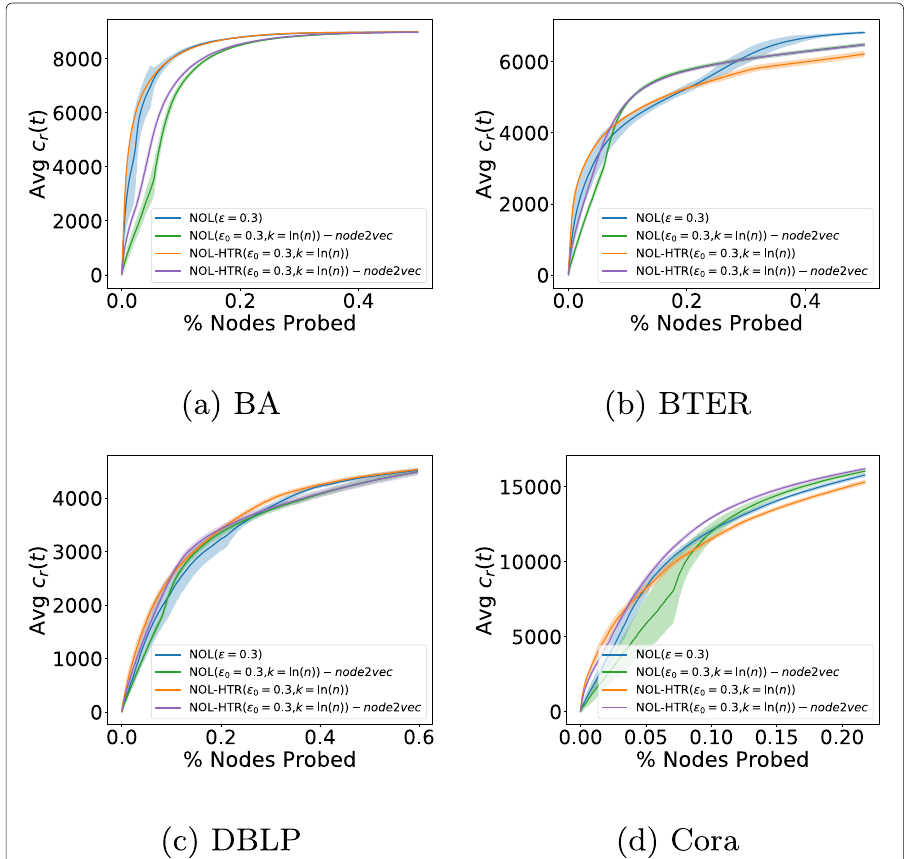
Fig. 10 Cumulative reward results using node2vec features. Improvement using the embedding as features is not straightforward. In the BA and DBLP cases, performance is the same or worse. In the BTER case, performance improves towards the beginning, but does not decisively outperform the default features in the end. Only in Cora does it appear that NOL-HTR with node2vec features decisively outperforms all of the other methods, but NOL with node2vec only outperforms the other methods towards the end of the experiment